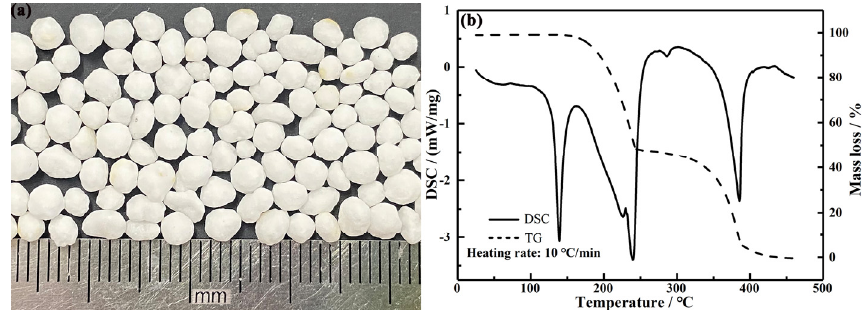
Figure 1. Morphology of carbamide granules used as the space holder for fabricating porous Mg alloy foams ( a ) and TG–DSC curves of carbamide ( b ), where the heating rate is 10 °C and atmosphere is Ar gas flow of 40 mL/min. Two categories of metal powder mixtures, Mg-9Al-1Zn (Mg-9 wt.%-1 wt.%Zn) and Mg-9Al-5Zn (Mg-9 wt.%Al-5 wt.%Zn), were made using commercial Mg (purity >